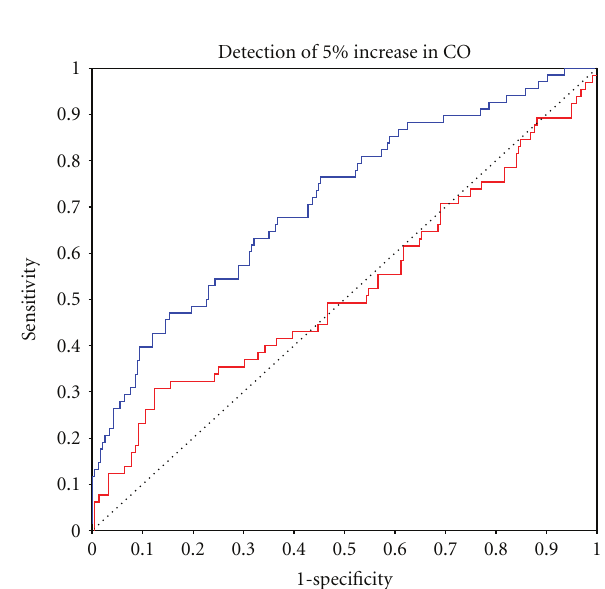
Figure 6: ROC curve for 70% certainty of detection of 5% increase in CO from baseline with PAC in red (AUC = 0 . 524), USCOM in blue (AUC = 0 . 708). Random values are represented by the dotted line (AUC = 0 . 50) and clinical e ff ectiveness AUC ≥ 0 .